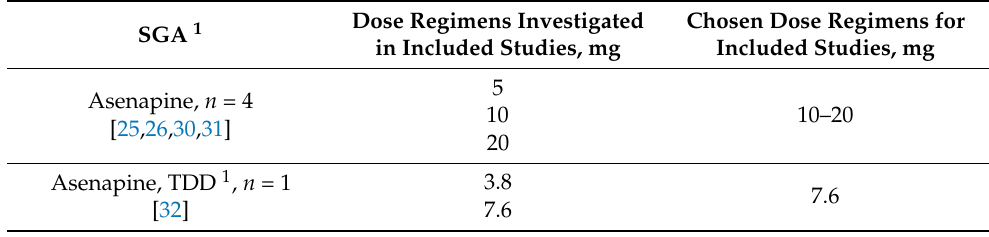
Table 2. Some of the included studies had multiple study-arms investigating different dose regimens. The first column shows the dose regimens investigated for different pines. The second column shows the dose regimen selected for inclusion in our